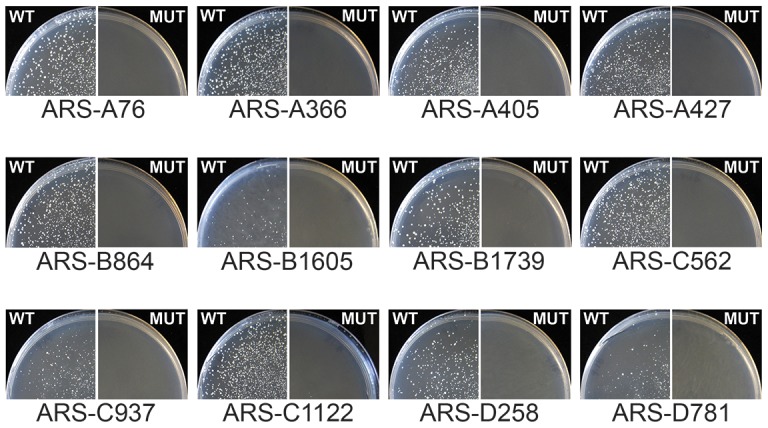
The GC-ACS is required for GC-ARS function.Wild type (WT) and mutant (MUT) alleles of the twelve ARSs indicated were cloned into a URA3 ARS-less vector and used to transform ura3 yeast on selective medium plates lacking uracil. Plates were grown at 30°C for five days before pictures were taken. Colony formation indicates plasmid maintenance and ARS activity. The GC-ACS was positioned <15 bp away from the 5′ endpoint in all ARS sequences. The sequences of the fragments tested are listed in Table S4.